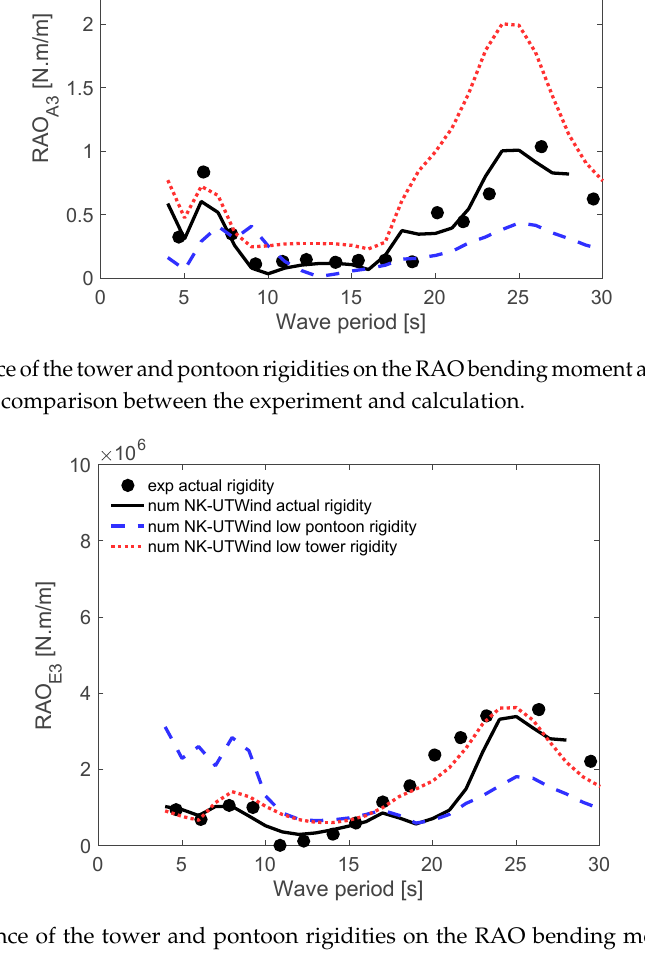
Figure 22. Influence of the tower and pontoon rigidities on the RAO bending moment at the side column gage (E3), and its comparison between the experiment and calculation.